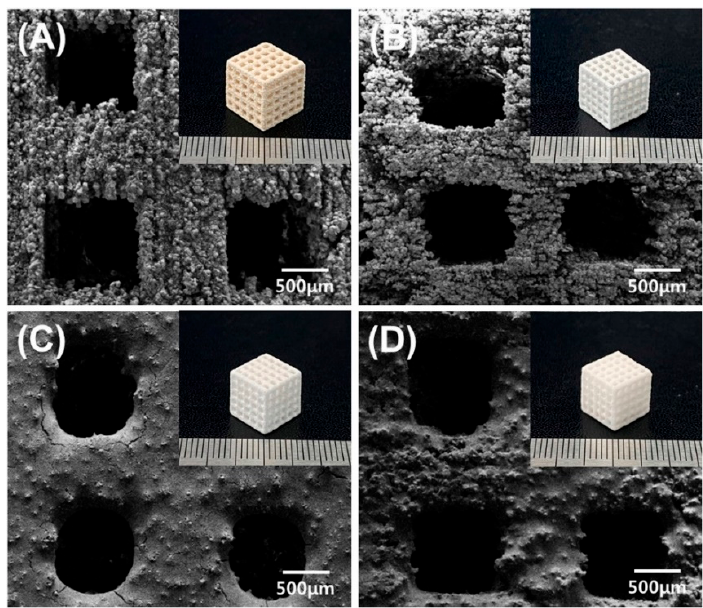
Figure 26. FESEM and (inset) optical images of the surface of the 3D printedscaffolds: ( A ) CSH; ( B ) BCP; ( C ) BCP/d-PCL; ( D ) BCP/m-PCL scaffolds (adapted with permission from reference [66]).